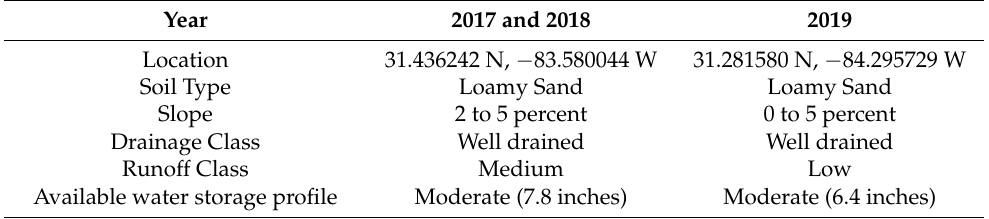
Table 1. Information on soil properties for the fields planted in cotton in 2017, 2018 and